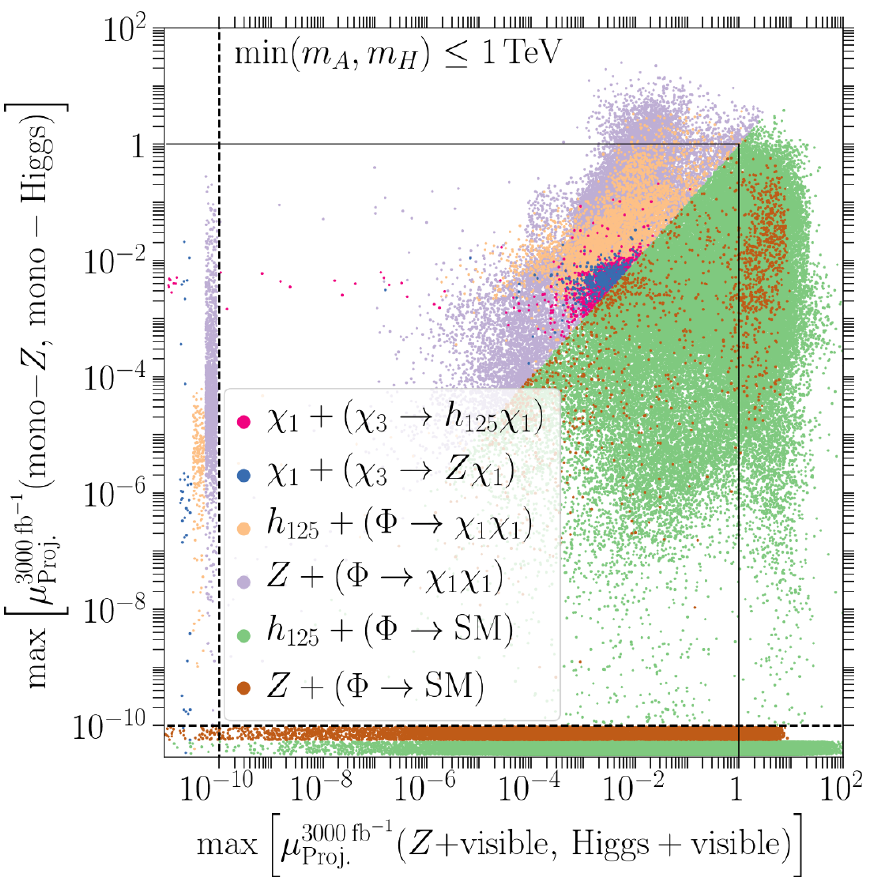
Figure 7 . Largest Z +visible or Higgs+visible signal strength ( x -axis) vs. the largest mono- Z or mono-Higgs signal strength ( y -axis) for points from our NMSSM parameter scan. The color coding denotes the Higgs cascade channel with the largest signal strength as indicated in the legend.